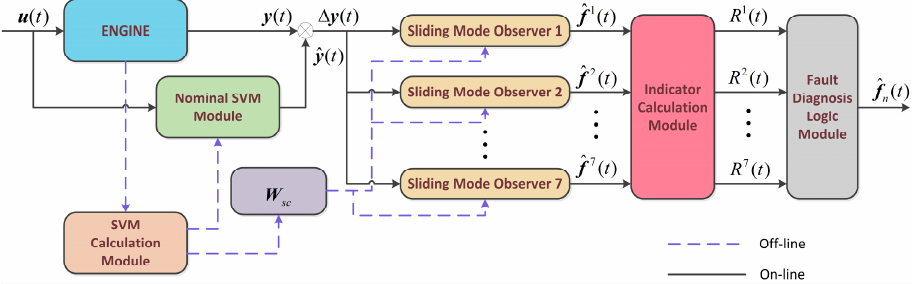
Figure 2. Robust sensor fault reconstruction using bank of sliding mode observers.